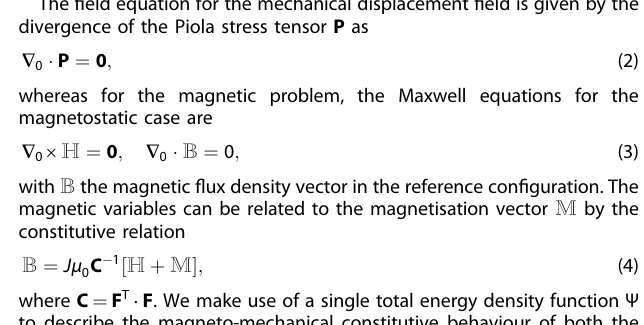
Fig. 5 Numerical application of the microscopic model on a bimorph and homogeneous cantilever beams. a Parallel magnetic actuation condition on a bi-layer cantilever beam with hybrid magnetic fi llers (soft- and hard-magnetic particles) in the top layer and a pure elastomeric matrix in the bottom layer. b Apparent stiffness of the bimorph beam after pre-magnetisation under null and magnetic actuations of 25 mT, depending on the fi ller content used in the upper layer: sMRE, 1:1 hybrid MRE and hMRE. c.1 , c.2 Magnetisation and magnetic induction fi elds within the sMRE beam after the magnetic actuation (25 mT), respectively. d.1 , d.2 Magnetisation and magnetic induction fi elds within the hybrid MRE beam after the magnetic actuation (25 mT), respectively. e.1 , e.2 Magnetisation and magnetic induction fi elds within the